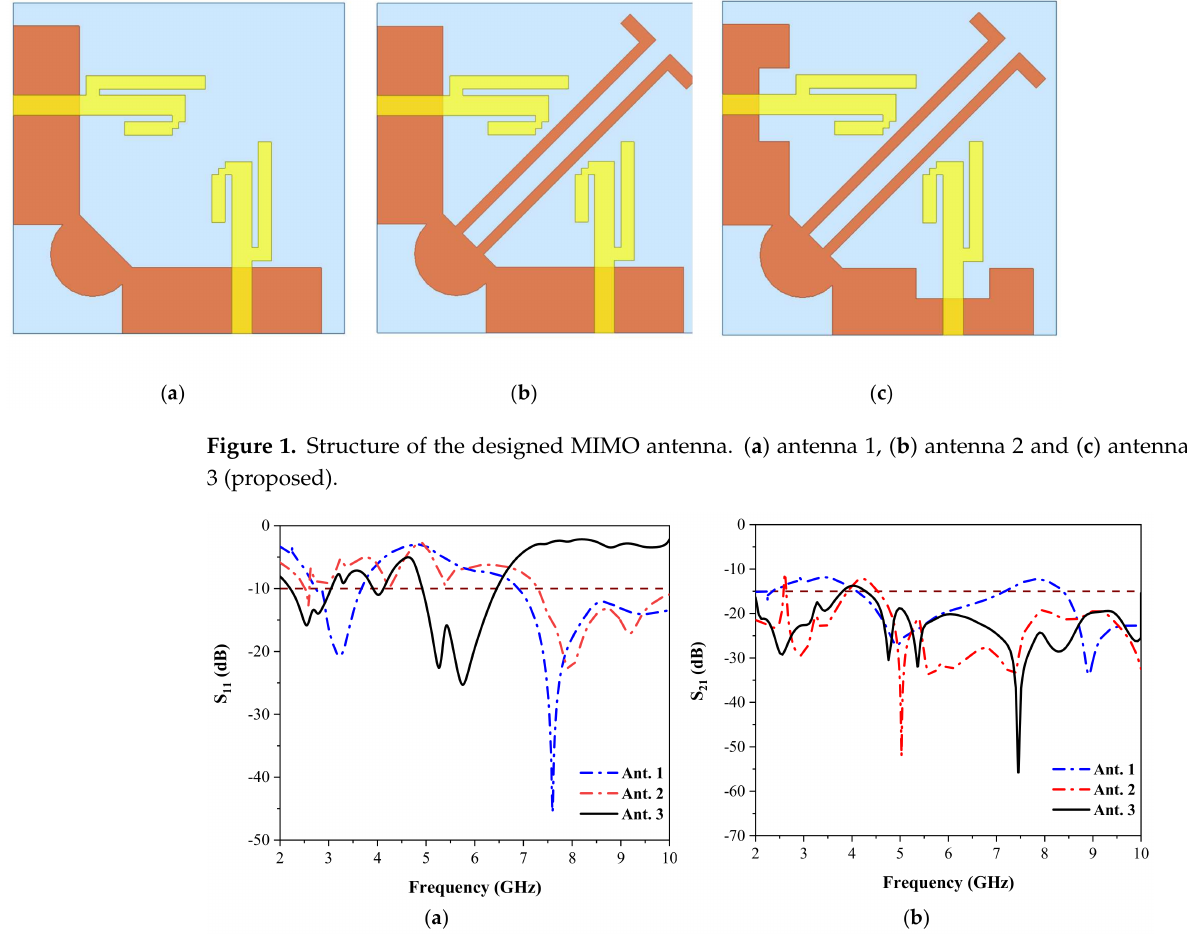
Figure 2. The simulated parameters of three antennas. ( a ) reflection coefficients, ( b ) isolation